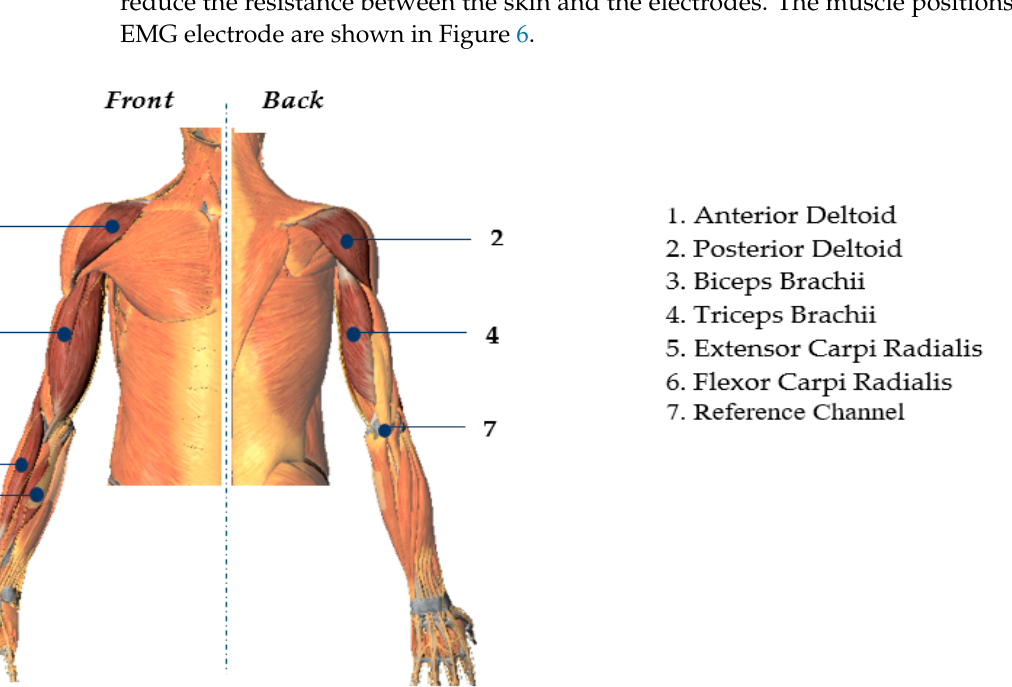
Figure 6. Electrode placement position on upper limb’s muscles. The numbers represent the locations of the muscles.